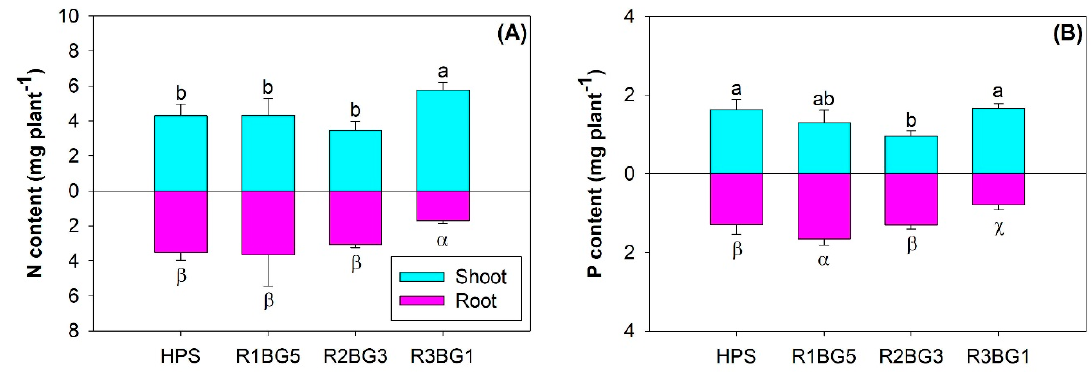
Figure 6. Nitrogen (left) and P (right) contents in the shoots and roots of Korean pine ( Pinus koraiensis ) seedlings under three LED-spectra treatments (R1BG5, R2BG3, and R3BG1) with the HPS spectrum as the control. Different letters indicate a significant difference according to Tukey’s test at the 0.05 level. Letters of a and b are labels for shoots; symbols of α , β , and χ are labels for roots. Subfigures A and B present N and P contents, respectively.